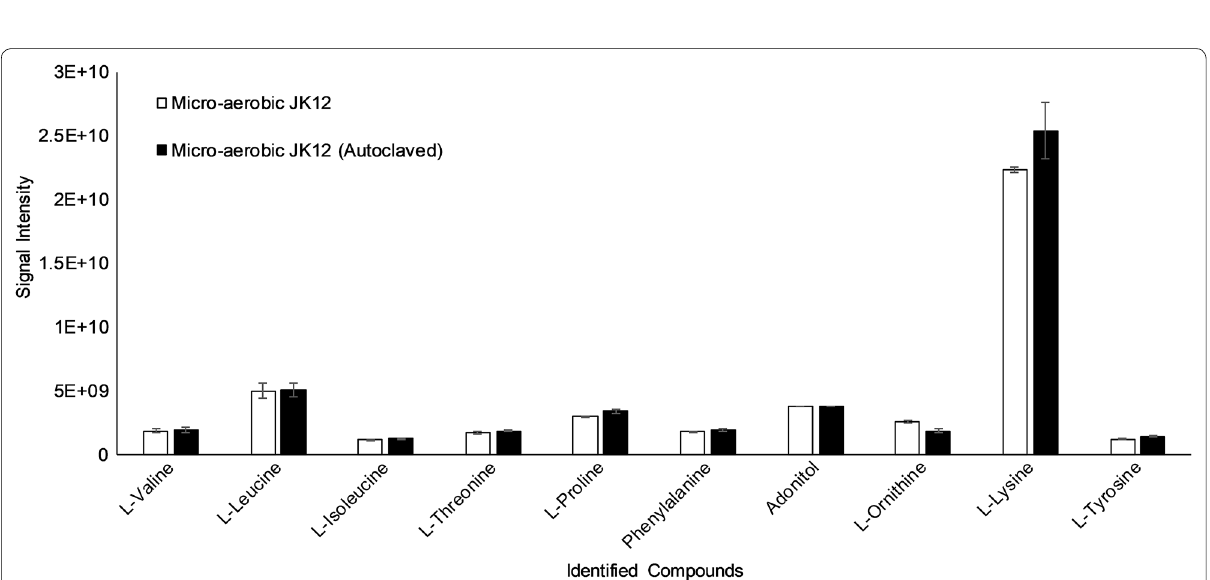
Fig. 7 Metabolic profiling of autoclaved micro-aerobic culture supernatant of JK12. All error bars indicate the SD of the three biological